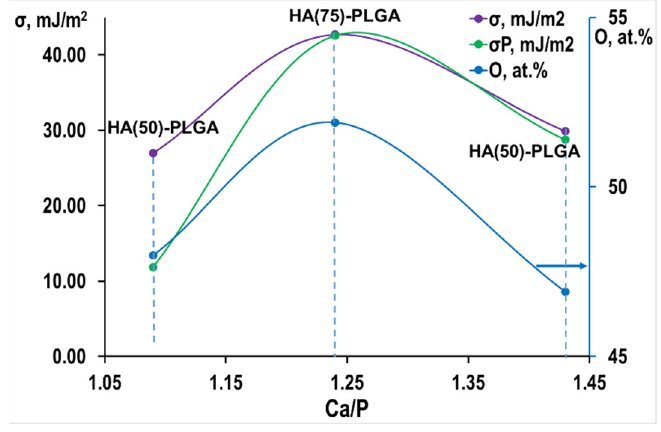
Figure 14. Oxygen content and the value of the polar component from the Ca/P ratio.